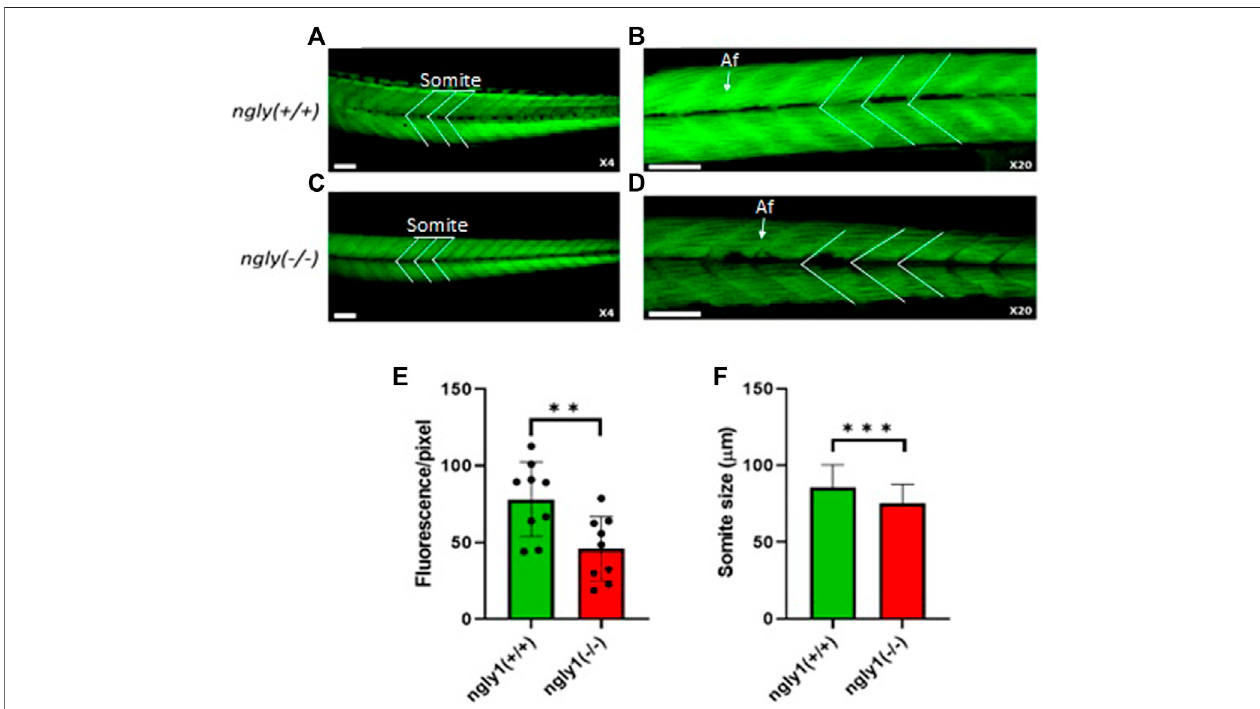
FIGURE5| Musclestructuremorphology.Representationof ngly1 ( +/+ ) (A,B) and ngly1 ( − / − ) (C,D) Phalloidinstainingforactin(A-X4andB-X20).Af=Actin fi laments. (E) Quanti fi cation analysis of the Phalloidin fl uorescence. t-test ( n = 9 in each group, ** p < 0.01). (F) Mean size of somite (µm). t-test ( ngly1 ( +/+ ) , n = 65. ngly 1 ( − / − ) , n = 79, *** p < 0.001). Scale bars — 50 µm.